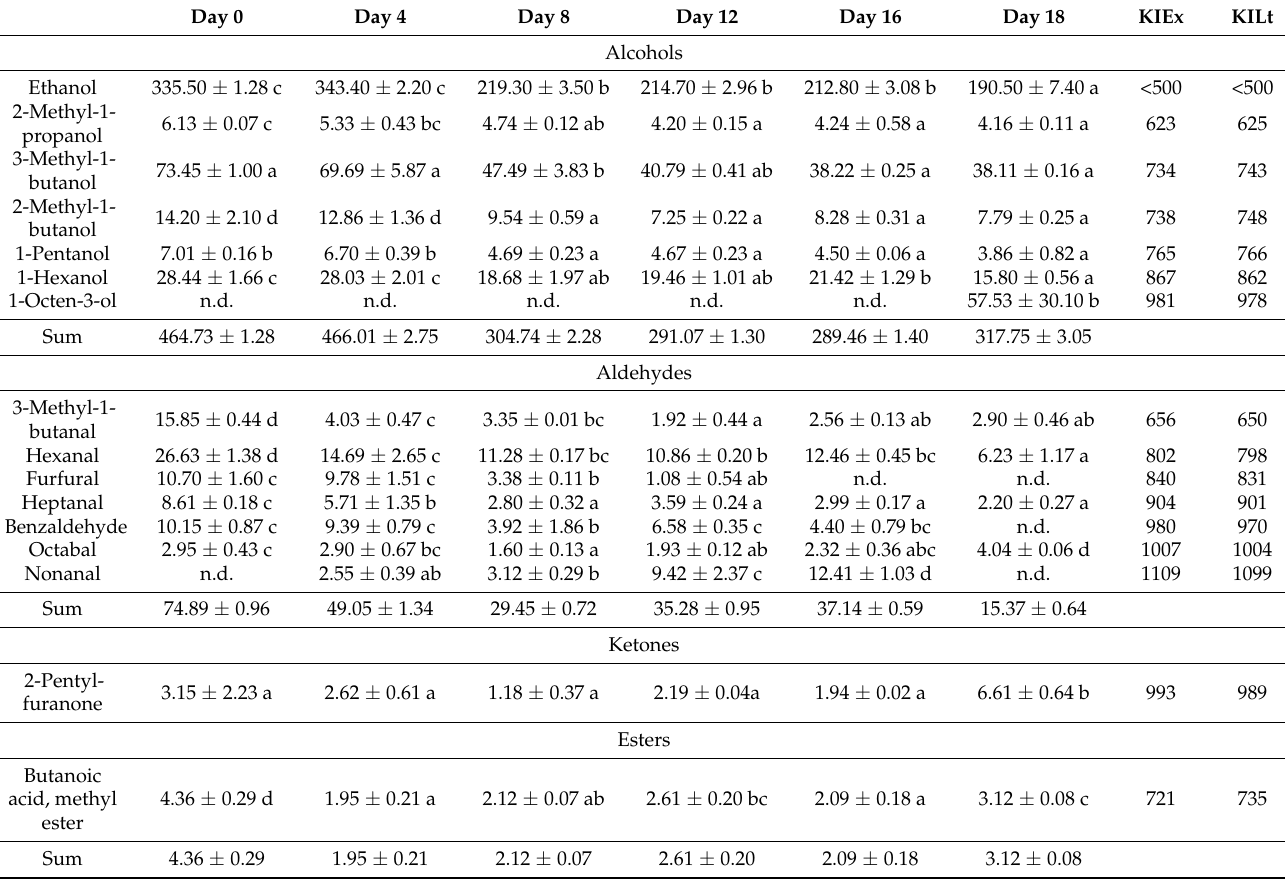
Table 2. Effect of storage time on evolution of volatile ( µ g/kg) in sourdough bread stored at 25 ◦